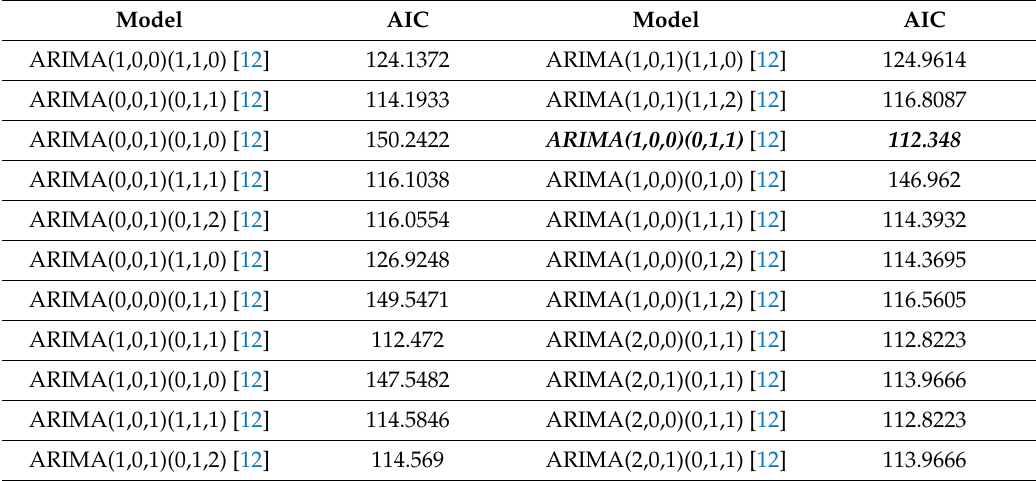
Table 2. Values of the Akaike information criterion (AIC) for suggested ARIMA